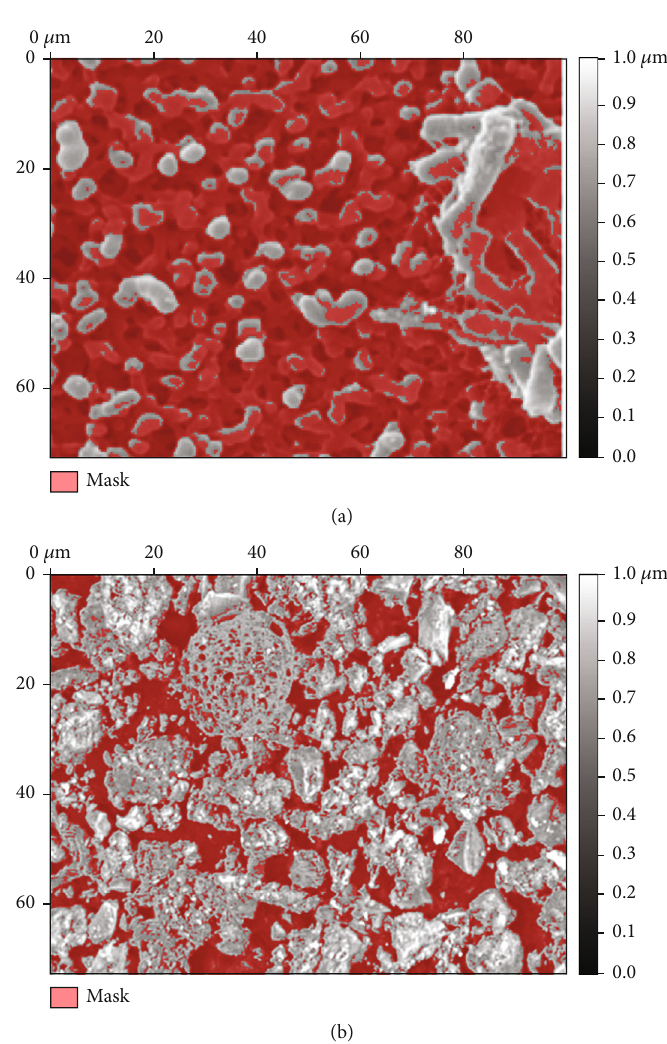
Figure 4: SEM of aerosols: (a) bioaerosols and (b)